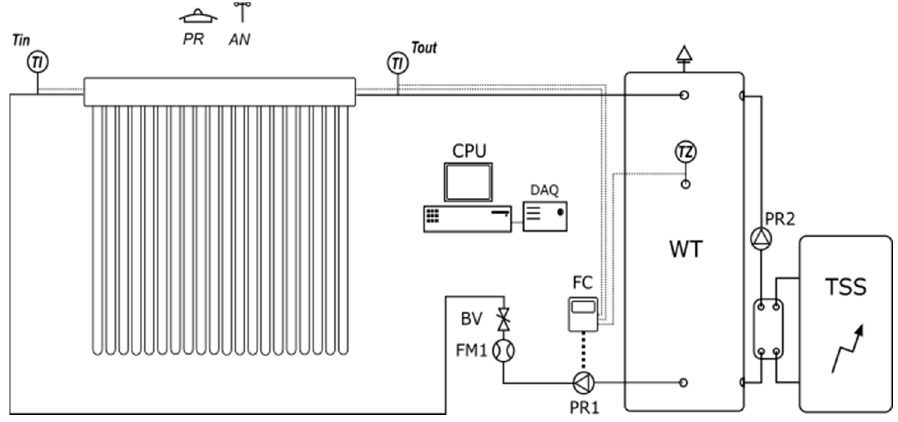
Figure 7. Test stand diagram.